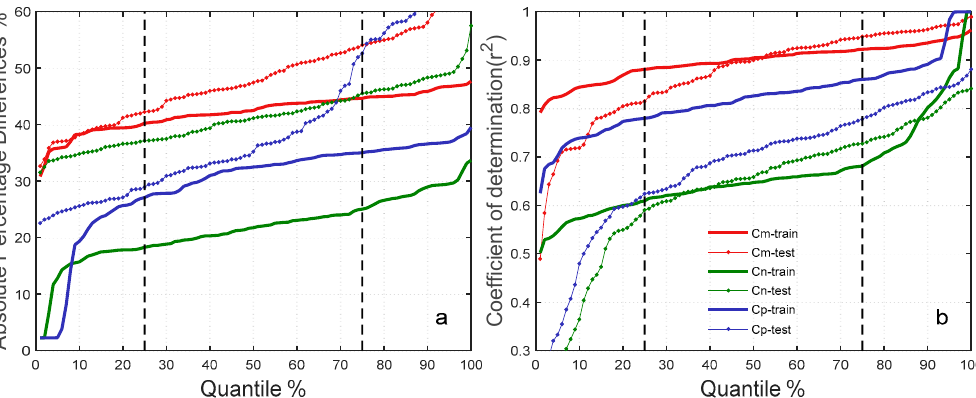
Figure 6. Cross-validation of random pick tests. ( a ) Absolute percentage di ff erences (in %) of randomly picked training and test datasets in estimation of PSC with respect to statistic quartiles. ( b ) Coe ffi cient of determination of randomly picked training and test datasets in the estimation of PSC with respect to statistic quartiles. The straight lines indicate the training datasets and broken lines indicate the test dataset. The dotted lines represent the statistical locations of the first and third quartiles. Red, green, and blue represent Cm, Cn, and Cp,